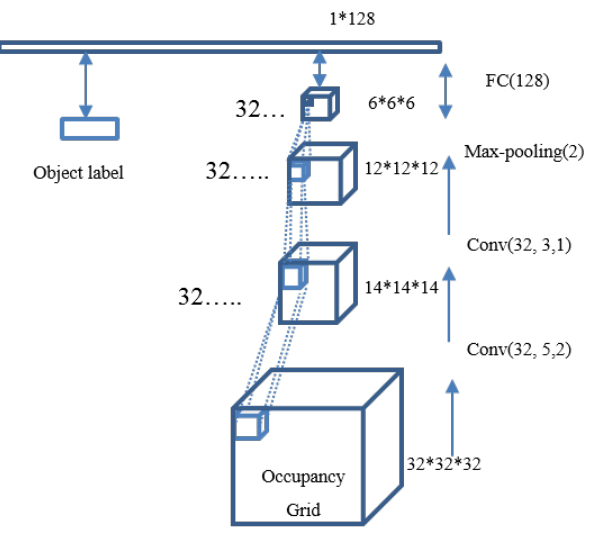
Figure 2. The conceptual framework of Vox-Net based feature extraction and classification.